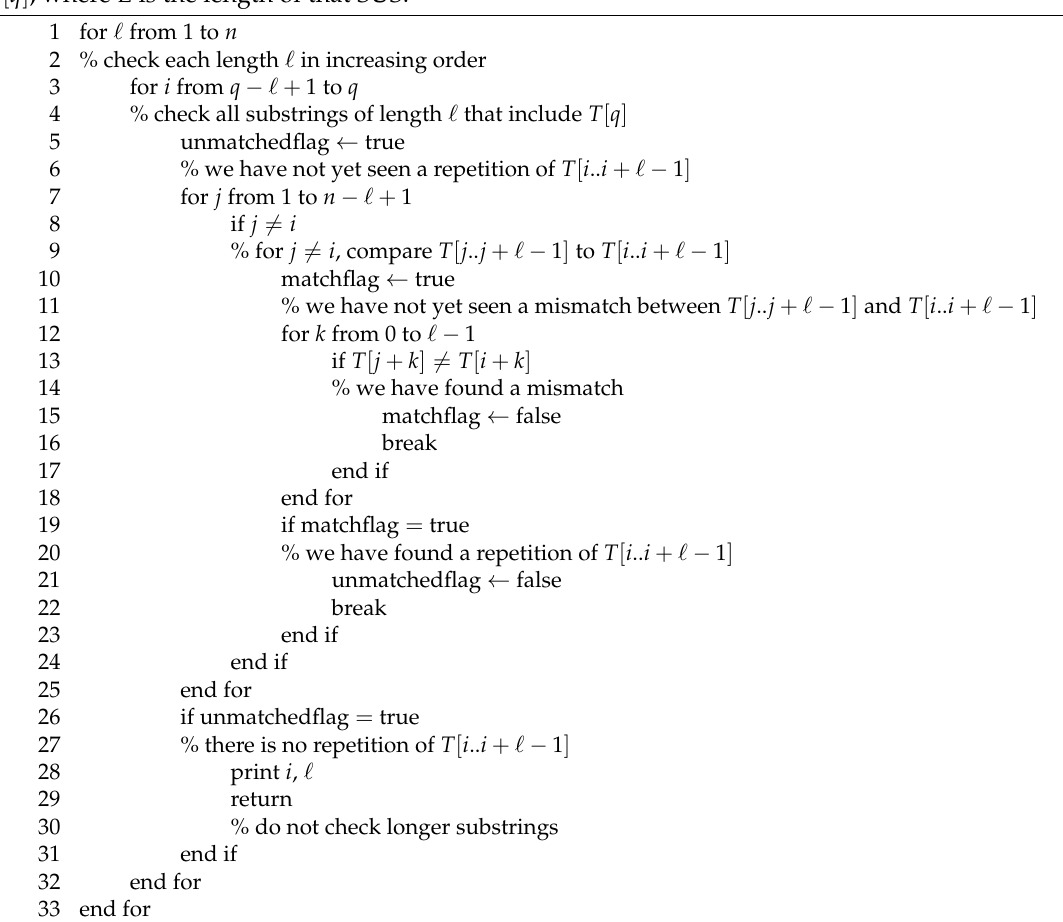
Algorithm 1 An O ( L 3 n ) -time algorithm to find an shortest unique substring (SUS) of T [ 1.. n ] containing T [ q ] , where L is the length of that